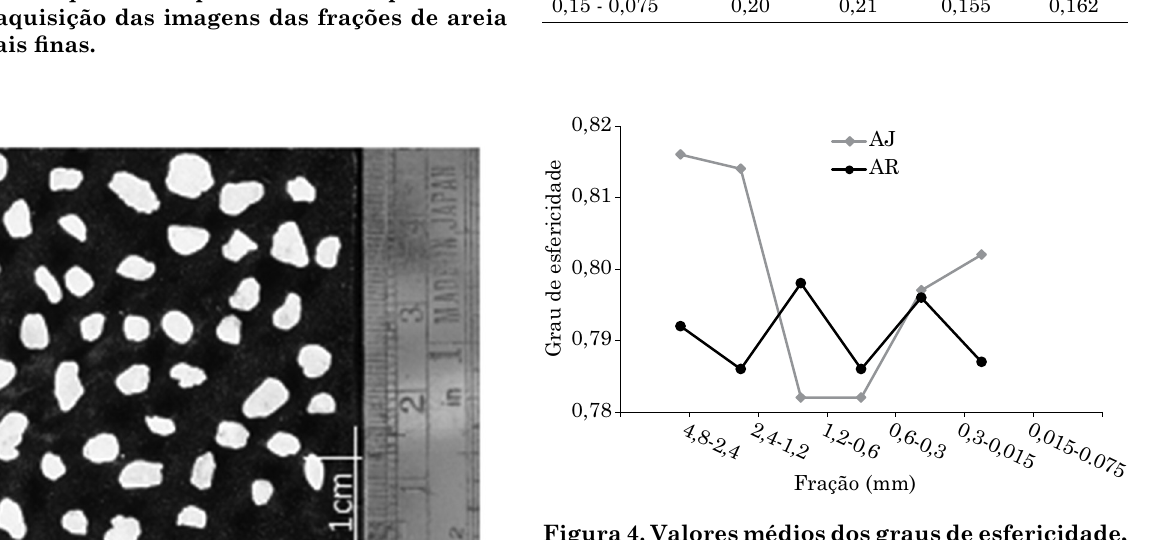
Figura 4. Valores médios dos graus de esfericidade, de acordo com a definição de Ritenhouse (1943), das frações da areia do cordão litorâneo (AJ) e areia de rio (AR) da região de Vitória, ES, obtidos pela análise